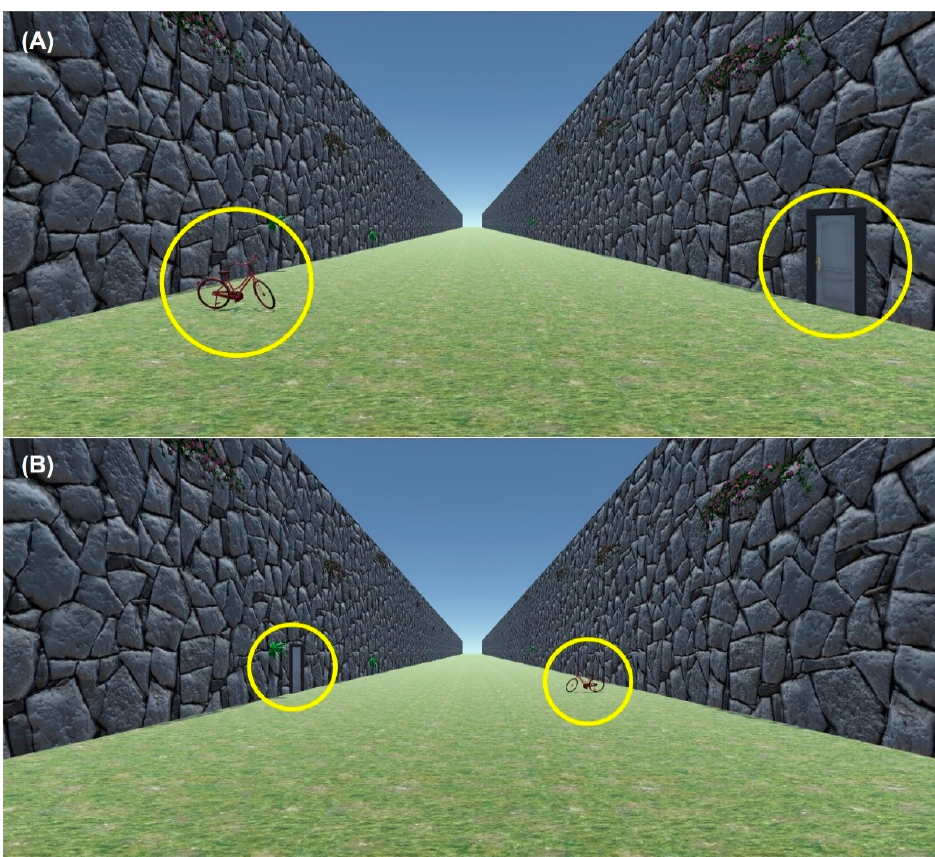
Figure 6. The pathway scene as Figure 4A with familiar objects: a bicycle and a door (highlighted by yellow circles) at near ( A ) and far ( B ) distances. The circles were not present in the display.